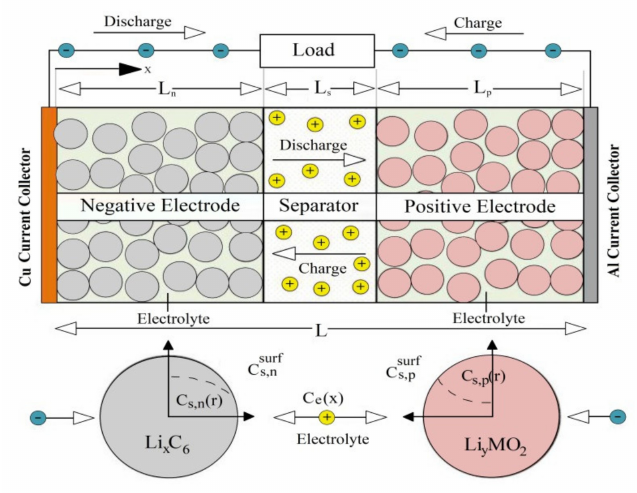
Figure 2. One-dimensional schematic of the electrochemical model of an Li-ion